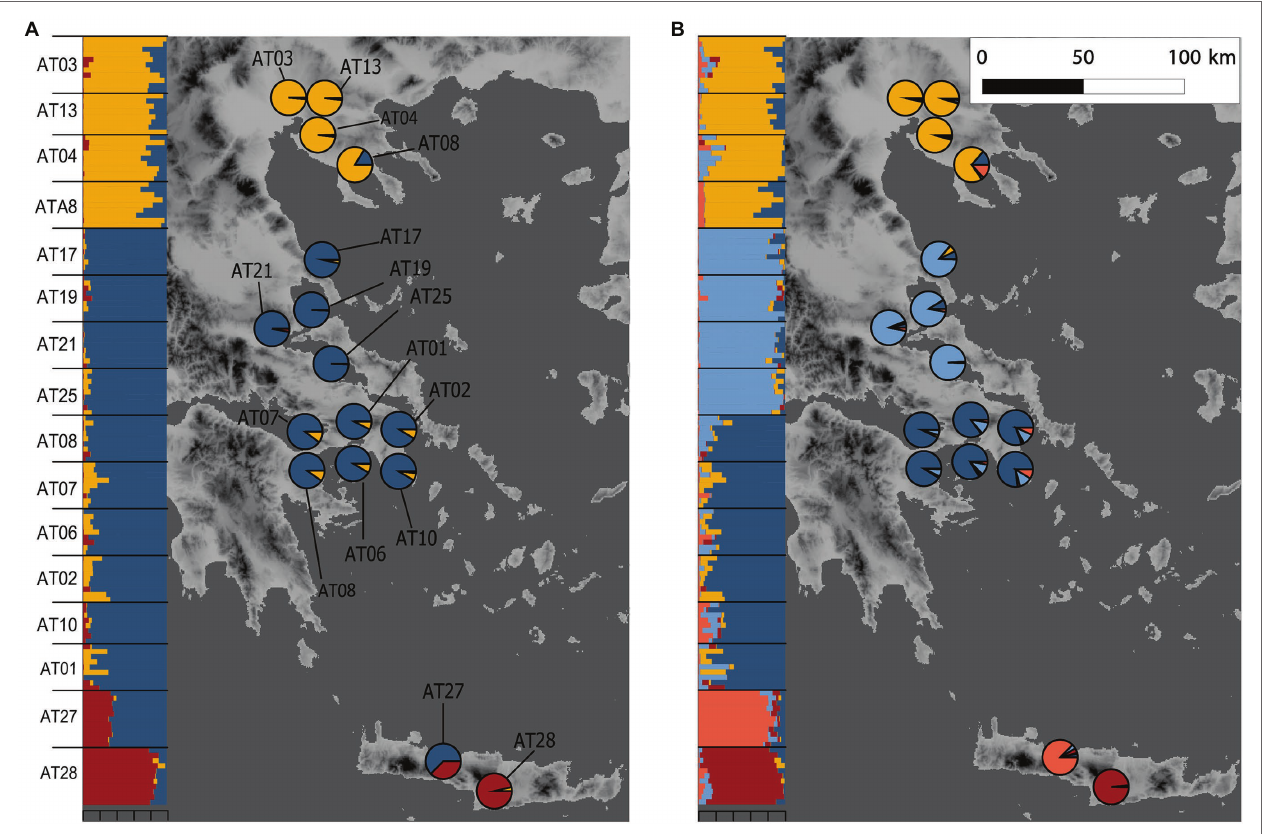
FIGURE 1 | Sampling localities of Alkanna and its genetic structure in Greece. Alkanna tinctoria was sampled across Greece, and A. sieberi on Crete island (localities AT27 and AT28). Geographical coordinates of sampling locations are provided in Supplementary Table S1 . Ancestry proportions inferred with TESS3 averaged for sampling locality are plotted as pie charts. Inset shows ancestry proportions from STRUCTURE as vertical bars where each vertical bar represents an individual and each color represents a genetic cluster. (A) K = 3, and (B) K = 5. Genetic structure estimates are based on RAD-seq data. For TESS3 and STRUCTURE, 7,935 and 1,000 SNPs, respectively, present across at least 90% individuals were used. The map of Greece was extracted from the WorldClim database (Hijmans et al.,